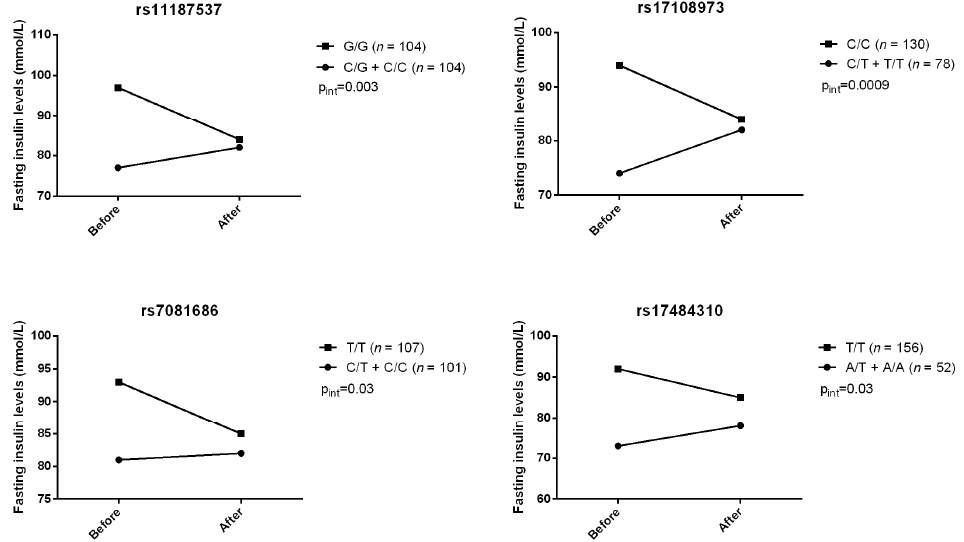
Figure 2. Gene–diet interactions on fasting insulin levels. p -Values for differences in insulin changes between genotype groups: rs111887537, p = 0.0045; rs17108973, p = 0.0012; rs7081686, p = 0.018; rs17484310, p = 0.031.